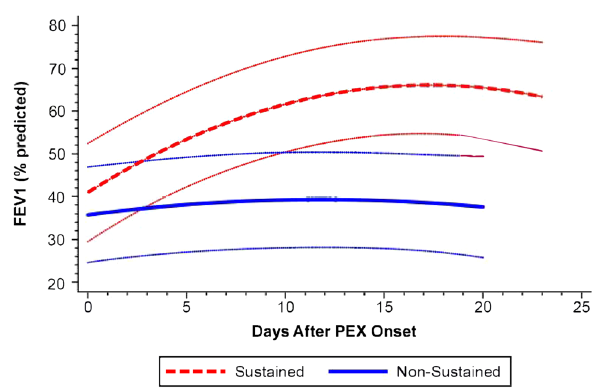
Figure 3. Model-predicted trends in FEV1% during PEX treatment for sustained and non-sustained symptom responders. Curves around each estimated trend reflect 95% C.I. of parameter